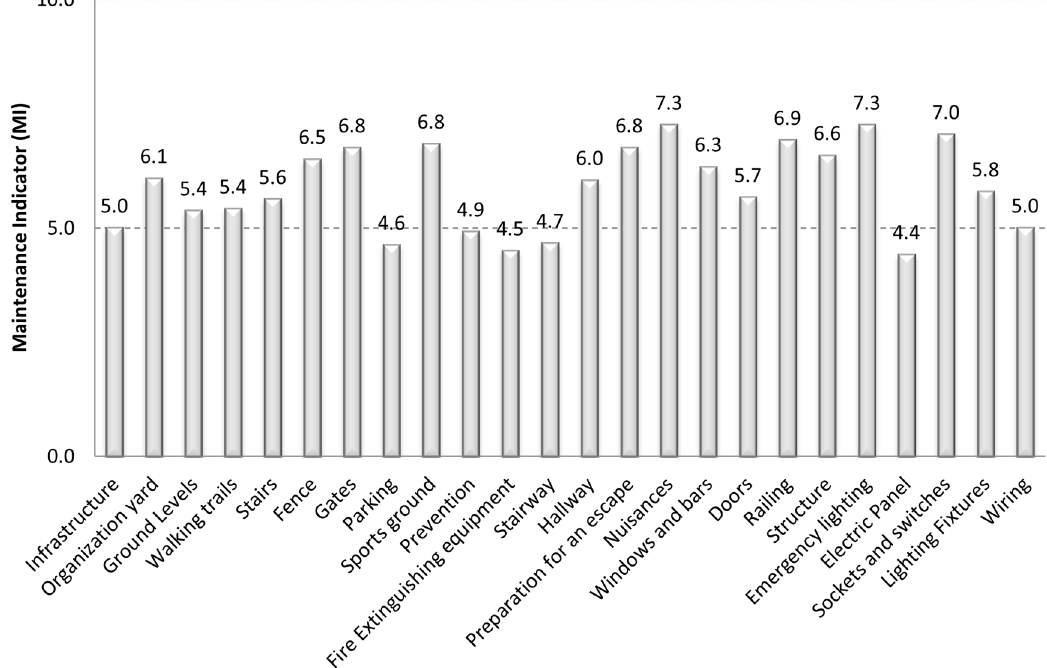
Figure 7. Mean maintenance indicator (MI) for different building and infrastructure systems—Educational Institutions.